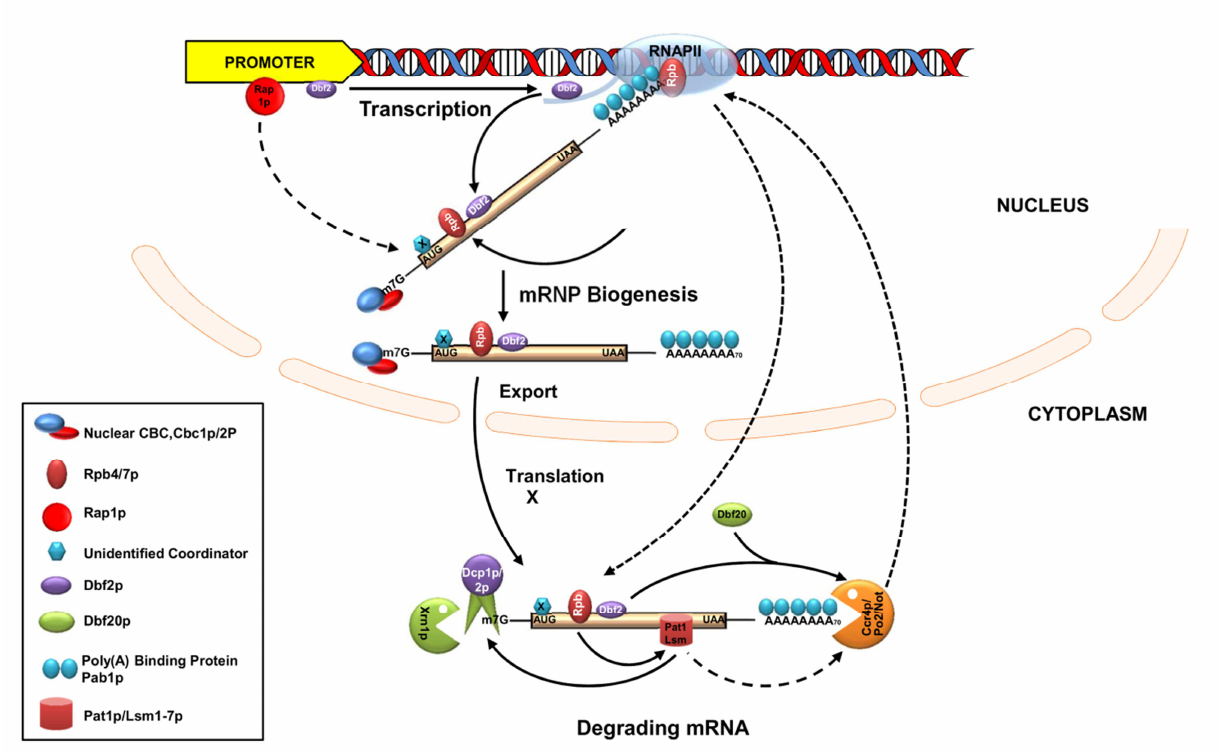
FIGURE 3: The interplay between the transcription and mRNA degradation in S. cerevisiae . Schematic diagram showing the functional coupling between the mRNA synthesis and degradation. Functional coupling is achieved by marking of the transcribing and maturing mes- sages by various coordinators either through the Rpb1-CTD of RNAPII in a transcription-dependent manner (such as those of Rpb4/7p and Dbf2p) or in a transcription factor (Rap1p)/promoter-dependent manner (such as that of a hitherto unidentified coordinator(s), coded X). The effect of various elements on the recruitment of diverse coordinators is indicated either by the solid (demonstrated) of dashed (postu- lated) arrow. Export-competent mRNPs undergo translation after arriving in the cytoplasm and are subsequently degraded via the general default decay pathway. During this stage, the Rpb4/7p dependent recruitment of Pat1/Lsm1-7p and influence of Dbf2p together with Dbf20 on the CCR4/NOT complex to further stimulate decay via the activation of other decay components are indicated by the solid arrow. Note that the demonstrated influence of Pat1/Lsm1-7p on the decapping complex is shown by the solid arrow, whereas its potential but ques- tionable impact on CCR4/NOT is indicated by a dashed arrow. Mutual influence of each process on the other is indicated by dashed arrows. Only relevant components are shown by annotated symbols. Other proteins which remain associated to translating/degrading mRNAs (such as eIF4E) during translation and decay are not